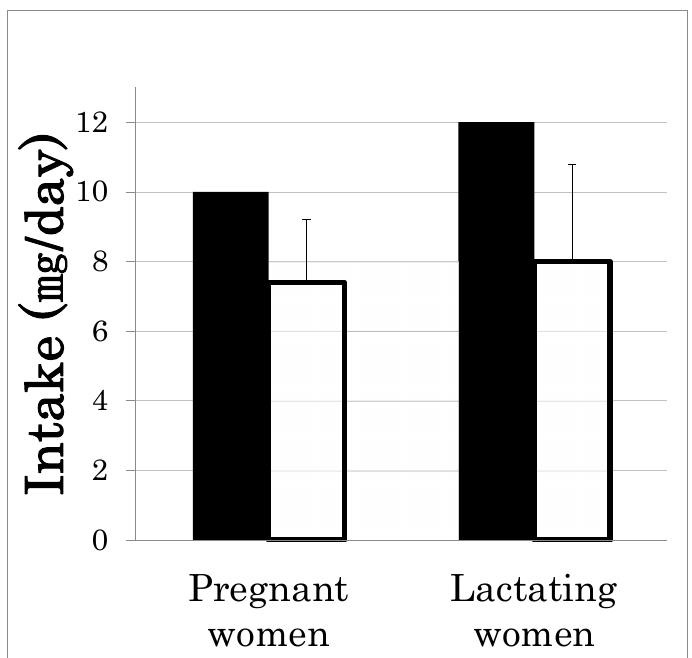
Figure 2. The comparison between the RDA and the actual zinc intake (mean ± SD) in pregnant or lactating women in Japan. The recommended dietary allowance (RDA) of zinc was obtained from the Dietary Reference Intakes for Japanese 2020 [4]. The RDA was 10 and 12 mg/day for pregnant and lactating women, respectively. The data for zinc intake were obtained from the National Health and Nutrition Survey 2017 in Japan [5]. The mean ± the SD of intake of pregnant and lactating women were 7.4 ± 1.8 mg/day and 8.0 ± 2.8 mg/day, respectively. Black bars indicate the RDA and white bars indicate the mean zinc intake.